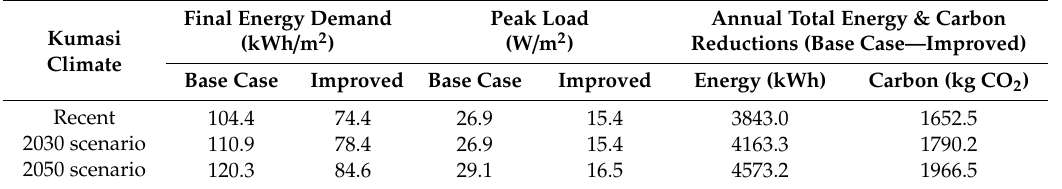
Table 12. Energy performances of the building as-built and with improvement strategies. Kumasi